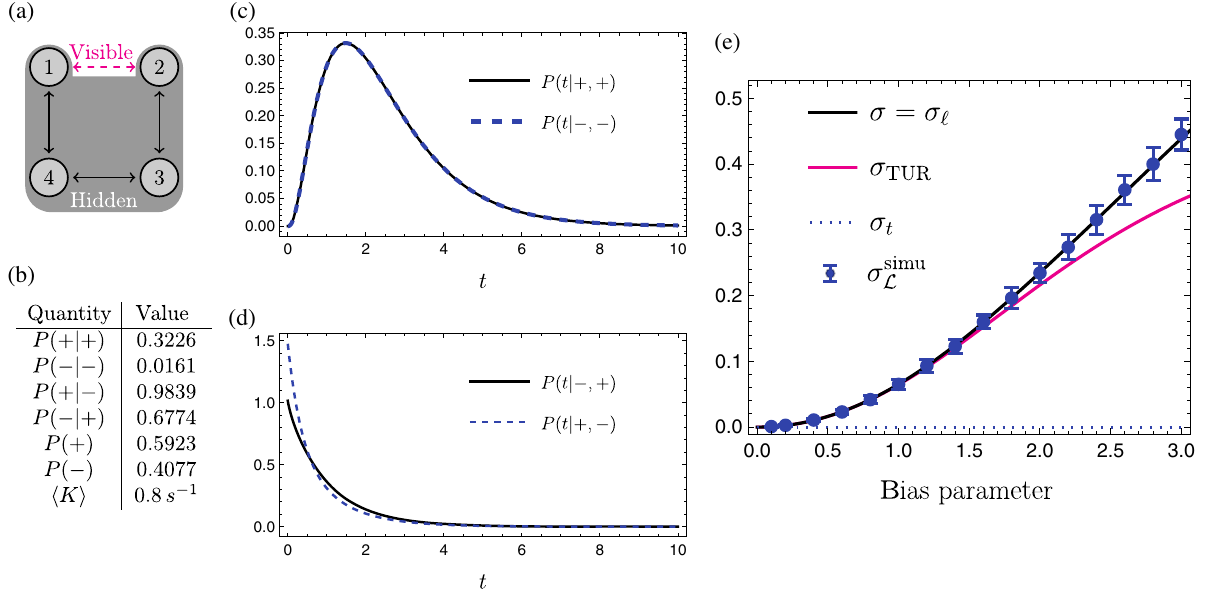
FIG. 7. (a) Ring with four states, ring network, and visible transitions þ ¼ 1 → 2 and − ¼ 2 → 1 . (b) Conditional and unconditional probabilities of transitions and the visible traffic rate. (c) Coinciding intertransition-time densities for repeated transitions and (d) for alternated transitions. (e) Summary of the entropy production rate inference scheme. Entropy production σ and the sequence of transition contribution σ l coincide, both in solid black; the intertransition-time contribution σ t in dotted blue is shown to vanish; the thermodynamic uncertainty relation σ is depicted in solid magenta, and simulations σ simu L in blue dots with error bars. All transition TUR rates are equal to 1 apart from W 14 , which is the exponential of the dimensionless bias parameter, and entropy production rate dimensions are k B =s